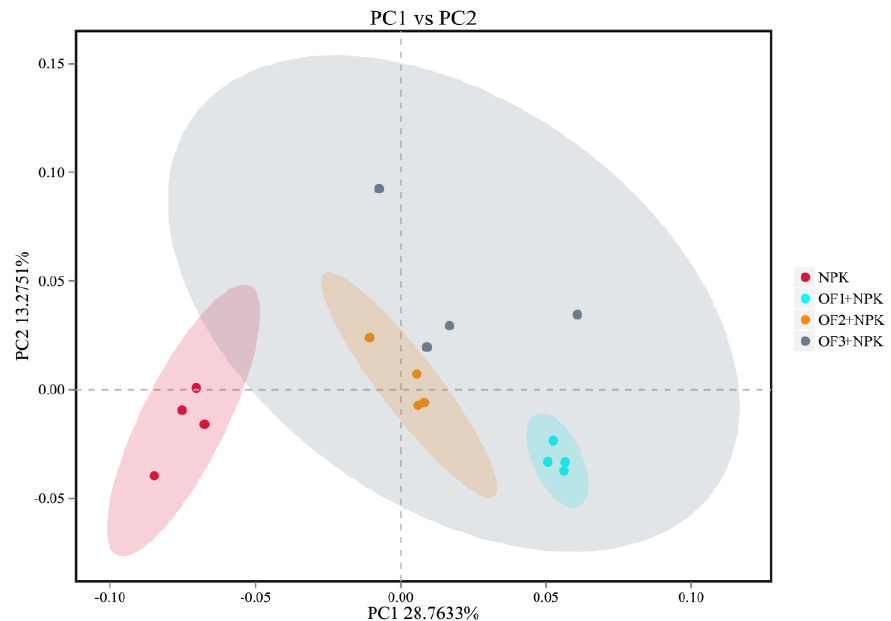
Figure 3. Principal component analysis of the soil bacterial community in a dry direct-seeded rice paddy soil under different fertilization treatments. NPK, conventional fertilization; OF1 + NPK, seaweed bio-organic fertilizer and NPK; OF2 + NPK, Jishiwang bio-organic fertilizer and NPK; OF3 + NPK, attapulgite organic fertilizer and NPK.